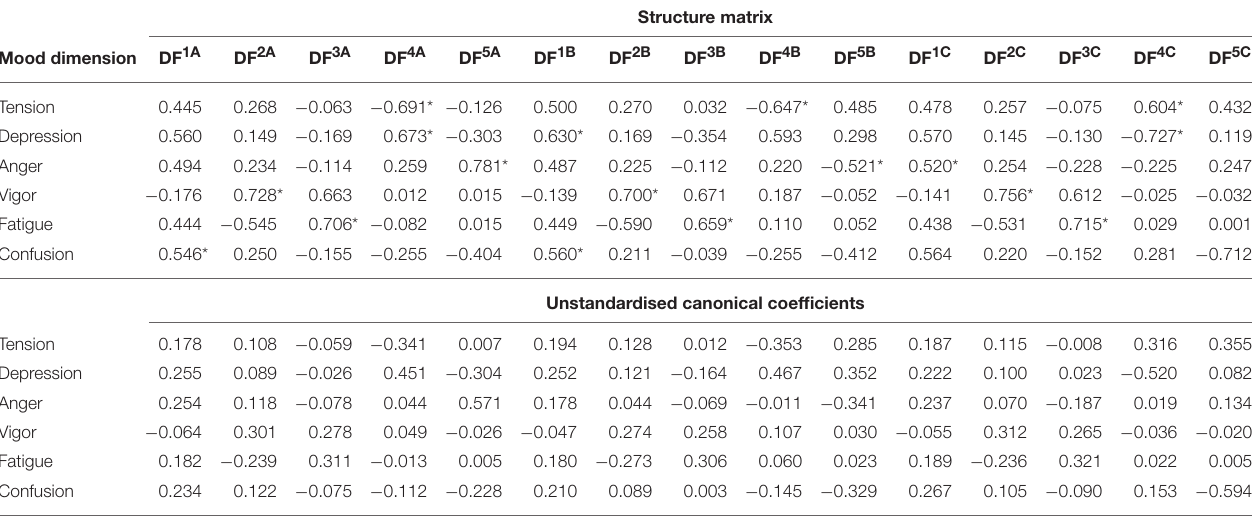
TABLE 6 | Structure matrix and unstandardized canonical coefficients for Sample A ( n = 2,364), Sample B ( n = 2,303), and Sample C ( n = 1,865).